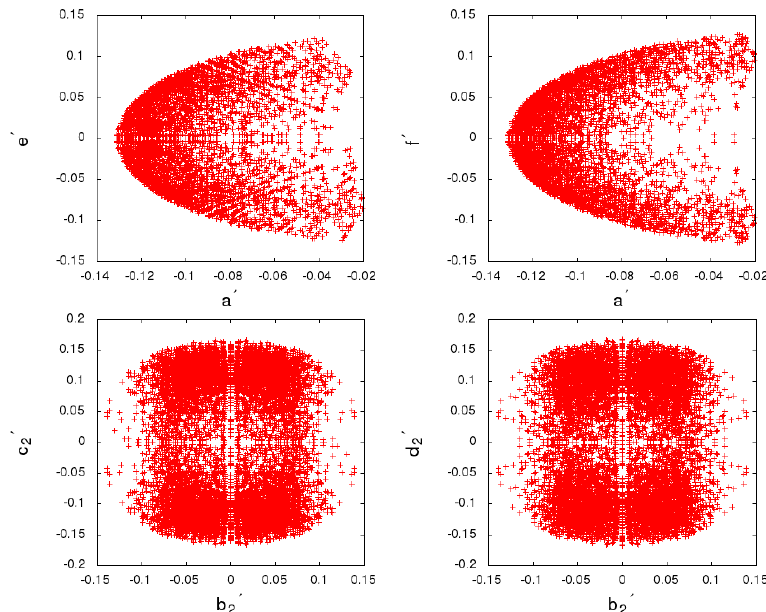
Figure 2 . Case-I: plots of the primed parameters for a inverted mass hierarchy.